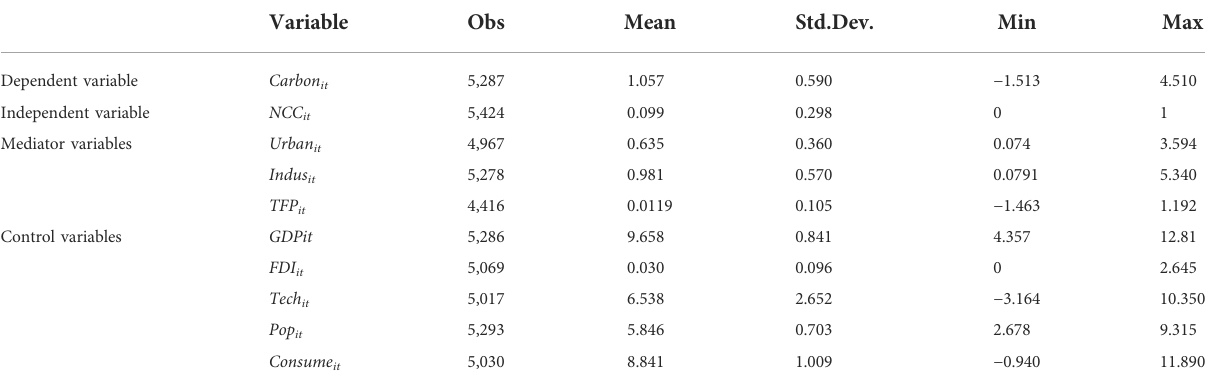
TABLE 1 Descriptive statistics of